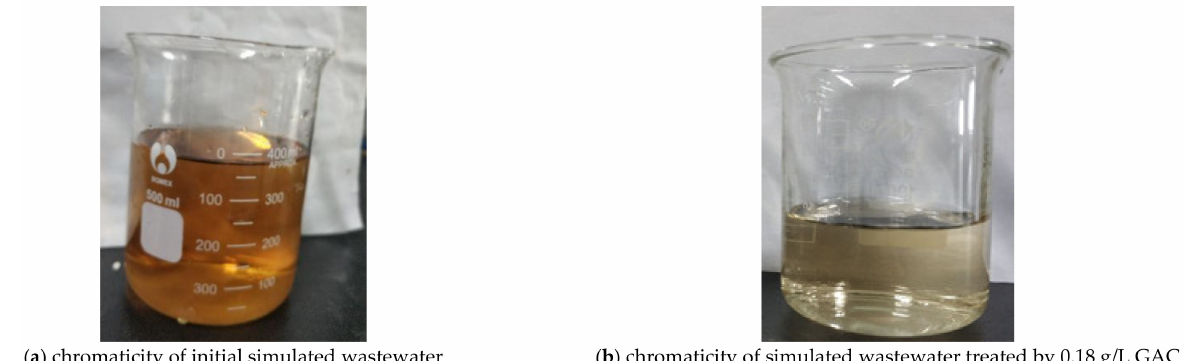
Figure 4. Chromaticity of simulated wastewater.